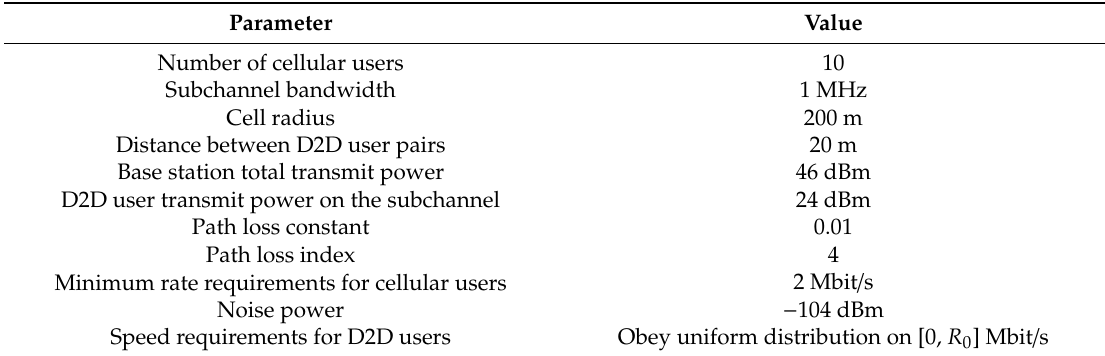
Table 2. Simulation